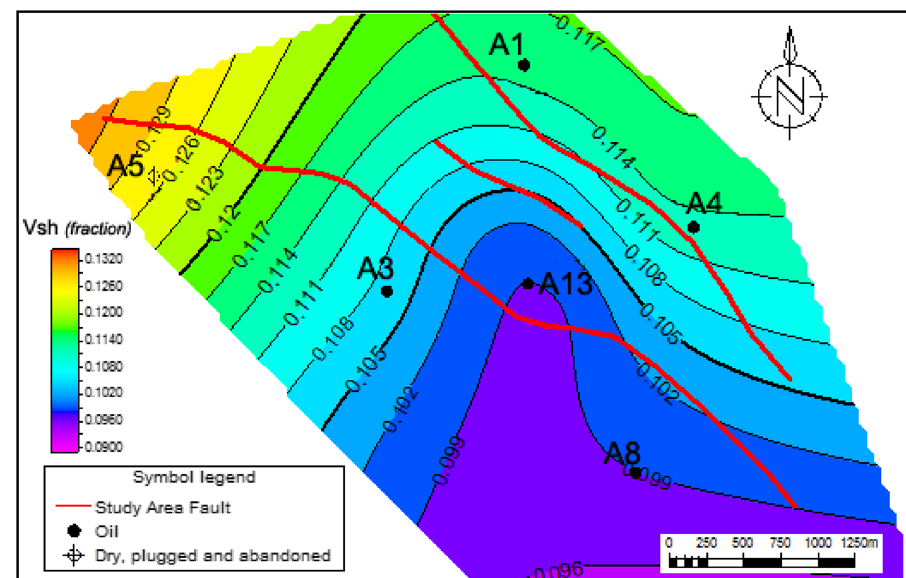
Fig. 14 Average shale content